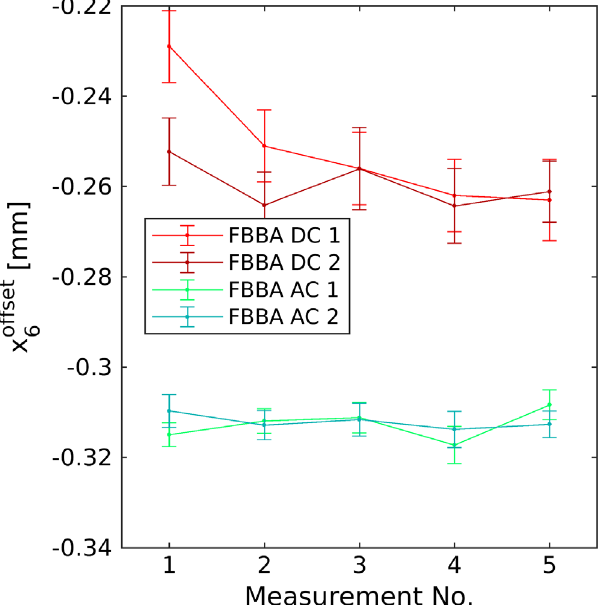
FIG. 16. FBBA measurements at the 32 BPMs nearest to skew quadrupole magnets. The top plot shows the results for the horizontal plane, while the bottom curves refer to the vertical plane. Results obtained via the ac skew quadrupole excitation are shown in blue while those from the dc scan are in red.